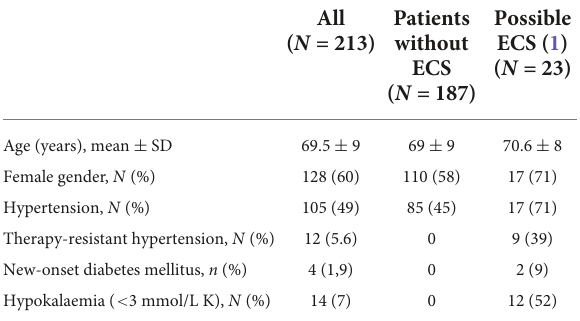
TABLE 2 Characteristics of patients without ectopic Cushing’s syndrome (ECS) and with possible ECS.